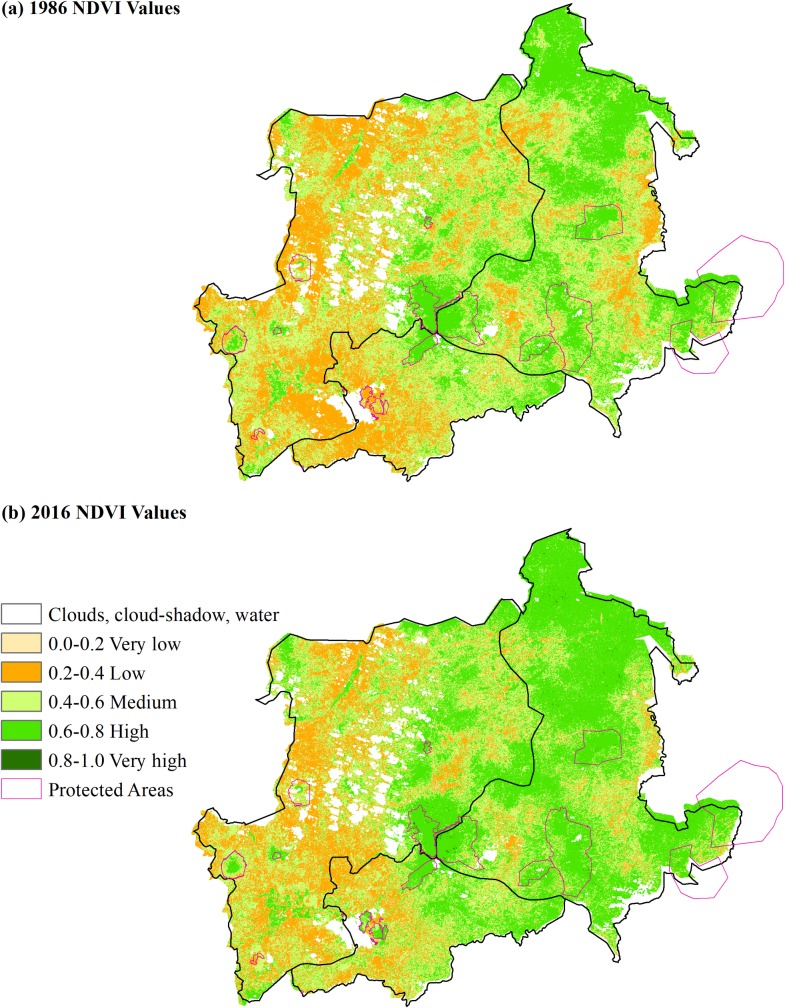
Variation in NDVI measures in Trifinio between 1986 and 2016.NDVI variation inside and outside PAs in Trifinio between 1986 (a) and 2016 (b). Pixels within PA polygons of selected forest PAs inside the Trifinio region were sampled as treatment units all control pixels are outside PAs. Clouds, cloud-shadow, and water pixels (Class 0) were masked out prior to cutting the rasters. The raster maps were reclassed to show variation in NDVI values as follows: Class 1 is >0 and <0.2, Class 2 is > 0.2 and < 0.4, Class 3 is >0.4 and <0.6, Class 4 is >0.6 and < 0.8, and Class 5 is >0.8 and < 1.0. There are no 1.0s in the raster database. A 3x3 mode filter is used on the reclassed pixels to reduce single vegetated polygons to approximately a hectare minimum. The map projection is UTM16N.